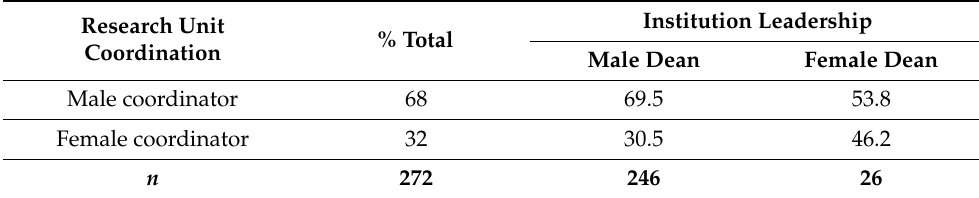
Table 6. Association between the Dean of the Institution and the Coordination of the R&D Unit according to gender (% column).